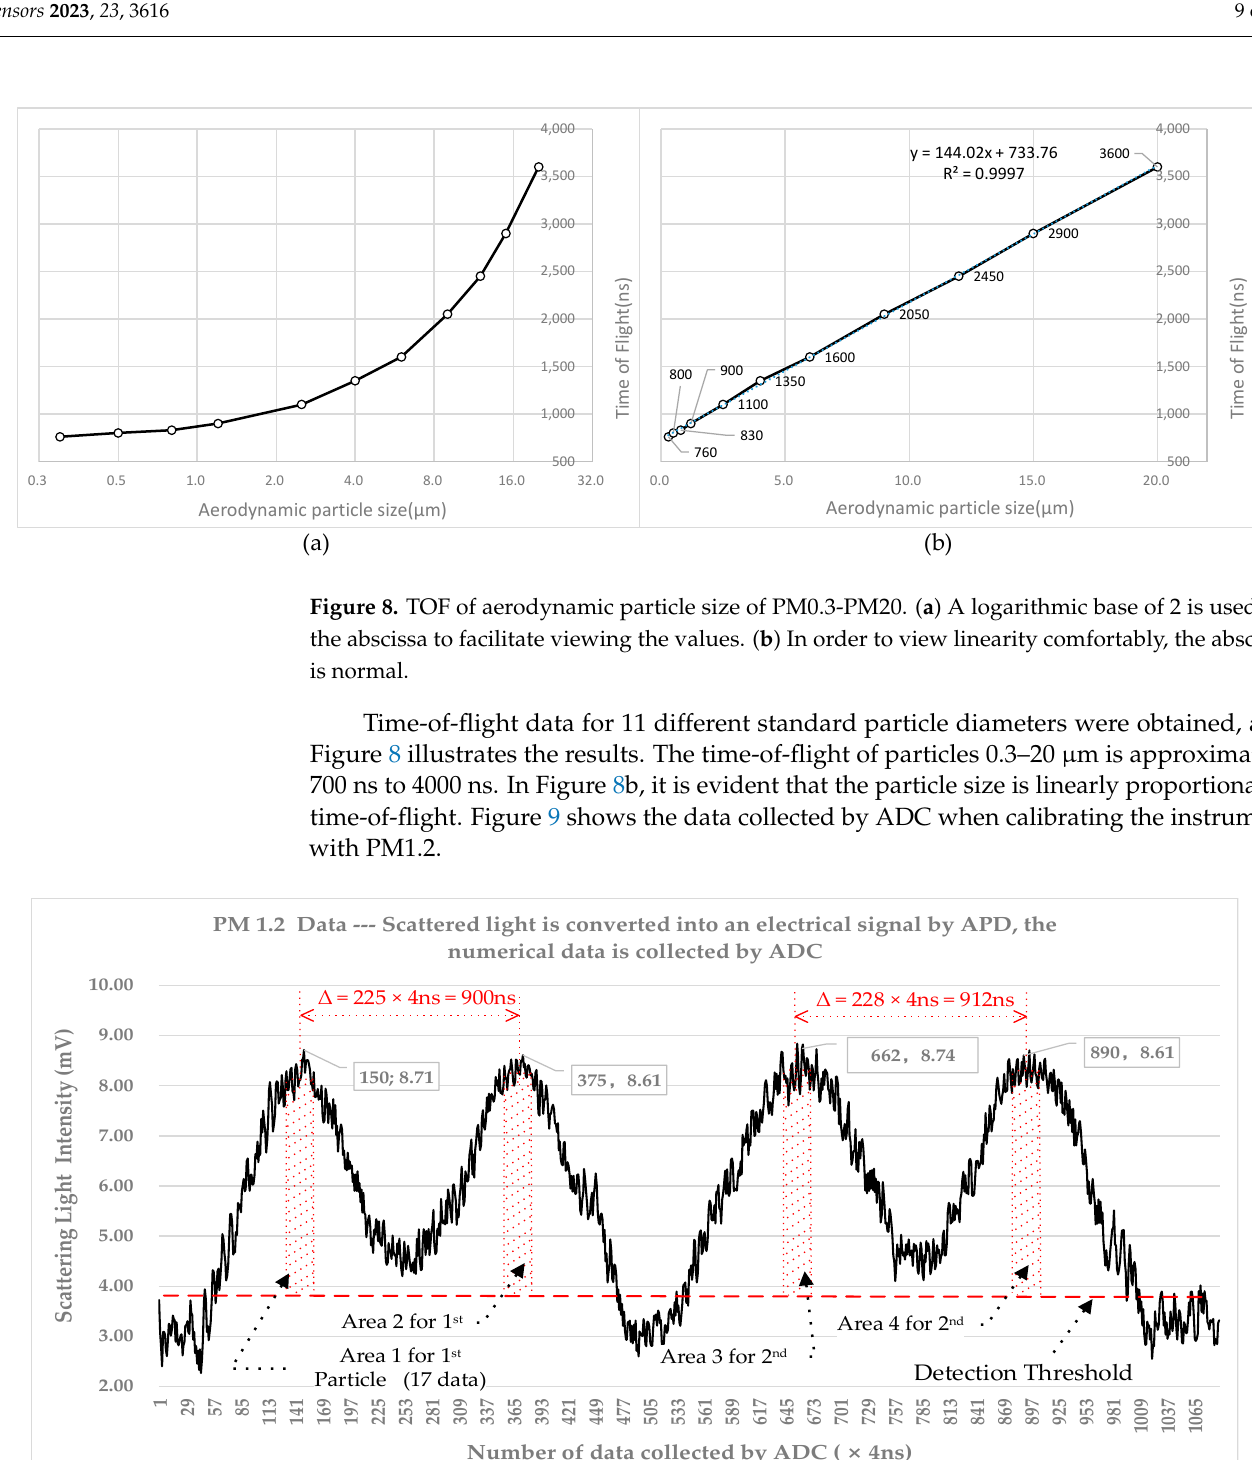
Figure 9. TOF and Scattering Light Intensity of two PM1.2 particles; TOF = ∆ = Numbers × 4 ns. As shown in Figure 9, the TOF of PM1.2 is around 900 ns. In order to normalize the data, for each particle with TOF, the scattering light intensity value is taken from the highest point on each peak to take its adjacent 16 points, and there are 34 points in total for the 2 peaks. The scattering light particle size of the first PM1.2 is area 1 plus area 2, and the scattering light particle size of the second PM1.2 is area 3 plus area 4. In order to obtain time-of-flight data for 0.3 µ m standard particles, one APD is utilized to receive forward-scattered light and the other APD for side-scattered light; these two APD’s signals are then summed for the same moment of data to increase the signal-